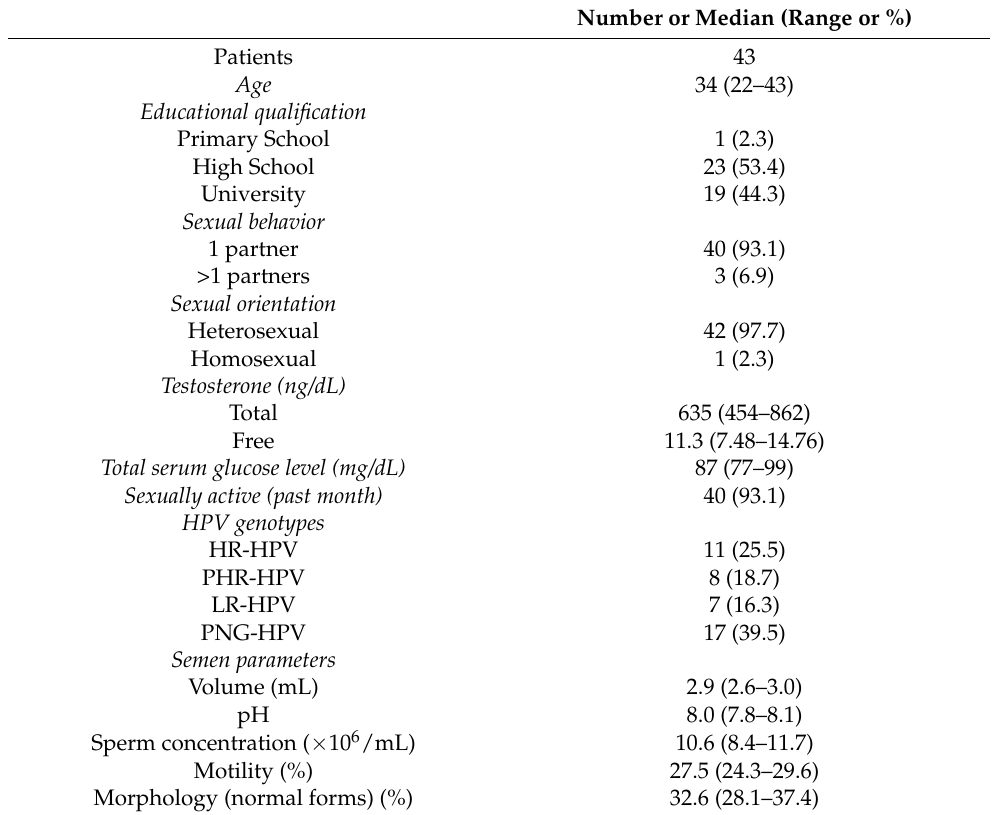
Table 1. The demographic and clinical patient data at the baseline.